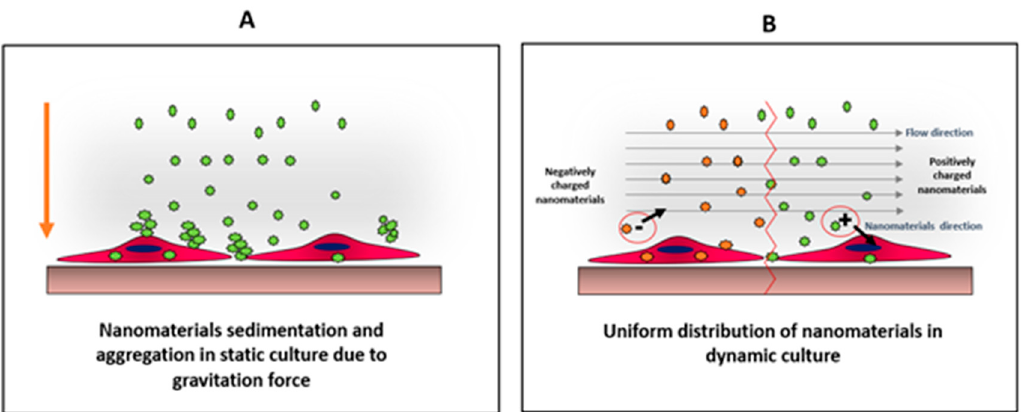
Figure 5. Comparison between distributions of nanomaterials under static ( A ) and dynamic ( B ) conditions. In static culture, nanoparticles tend to sediment and aggregate due to their high surface energy. This condition create physiochemical stress on cells, which might alter cells viability as well as particles uptake On the other hand, in dynamic culture, the particles will be uniformly distributed allowing better cellular interaction, which can be charge-dependent as the direction of the negatively-charged particles will be away from the cell surface, unlike positively-charged particles, where the particle direction will be towards the cell surface. Adapted from Mahto et al. [43].